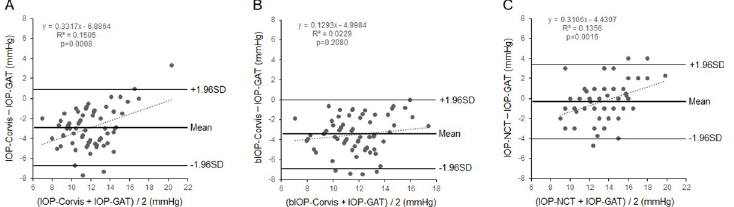
Fig 1. Bland–Altman plots between IOPs obtained with the Corvis ST, GAT, and CT-90A. A, IOP-Corvis and IOP-GAT. B, bIOP-Corvis and IOP-GAT. C, IOP-NCT and IOP-GAT. The mean values and 95% LOA are indicated by bold lines and solid lines, respectively. IOP, intraocular pressure; IOP-Corvis, the IOP obtained by Corvis ST; bIOP-Corvis, corrected IOP-Corvis; IOP-GAT, the IOP obtained by Goldmann applanation tonometry; IOP-NCT, the IOP obtained by CT-90A tonometer; LOA, limits of